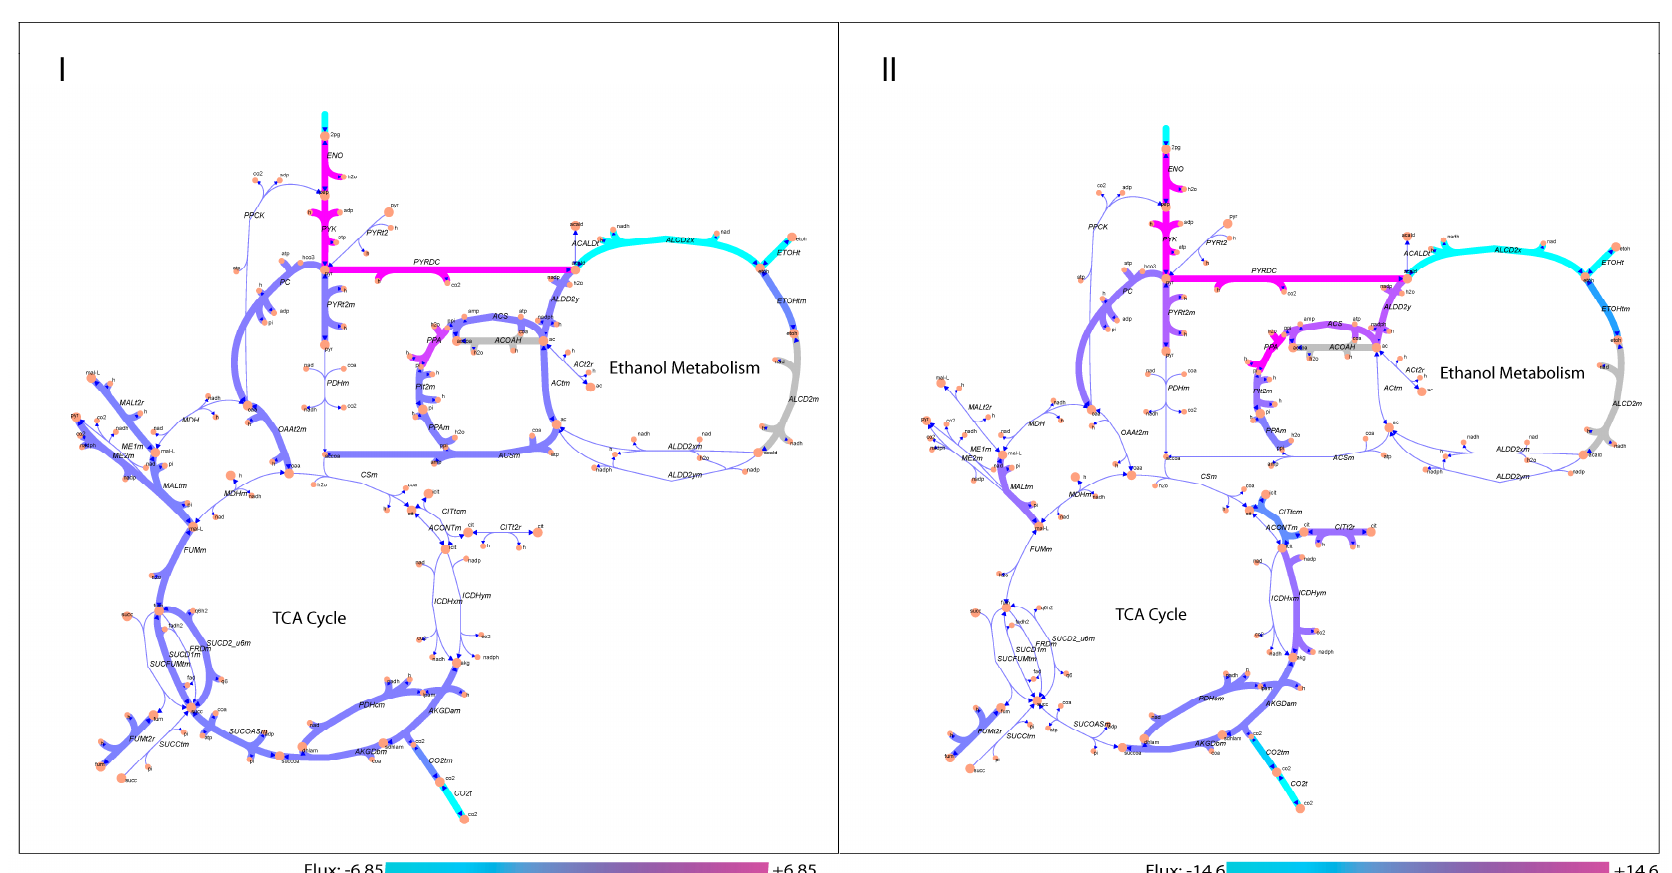
Figure 3. Network maps of central carbon metabolism. Network fluxes were determined for Case I ( left ) and Case II ( right ) where the network illustrates the optimal solution from flux balance analysis (FBA). Note that the scales, as indicated in the legends, are different for Case I and Case II.